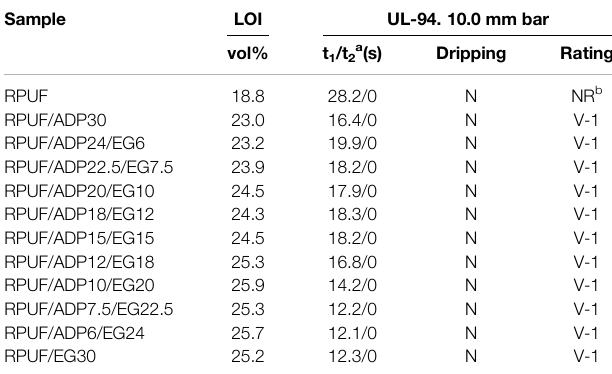
TABLE 3 | TGA results of RPUF and FR-RPUF composites under N 2 . Flame retardant performance. Samples